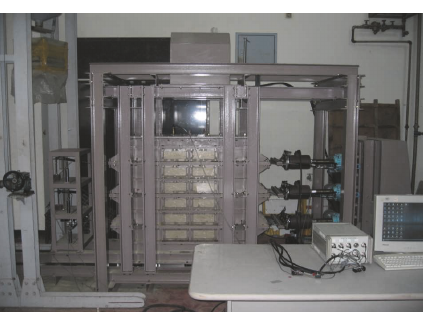
Figure 1: Multilayer pullout test apparatus